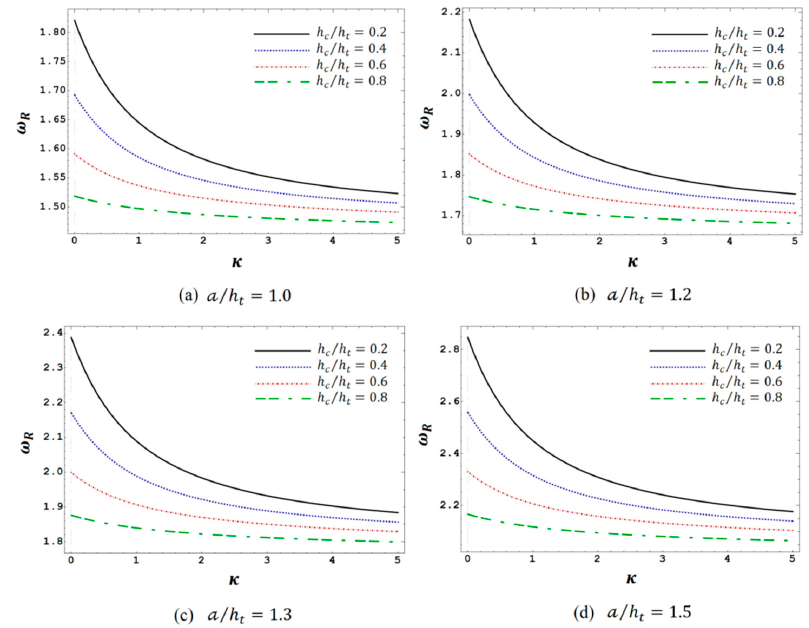
Figure 6. Variation of the first-order nonlinear-to-linear frequency ratio of a GPL-reinforced sandwich beam due to an increased power-law parameter for different core-to-beam thickness ratios and amplitudes of vibration ( N = 10, Γ b = 1%, L / h t = 10).